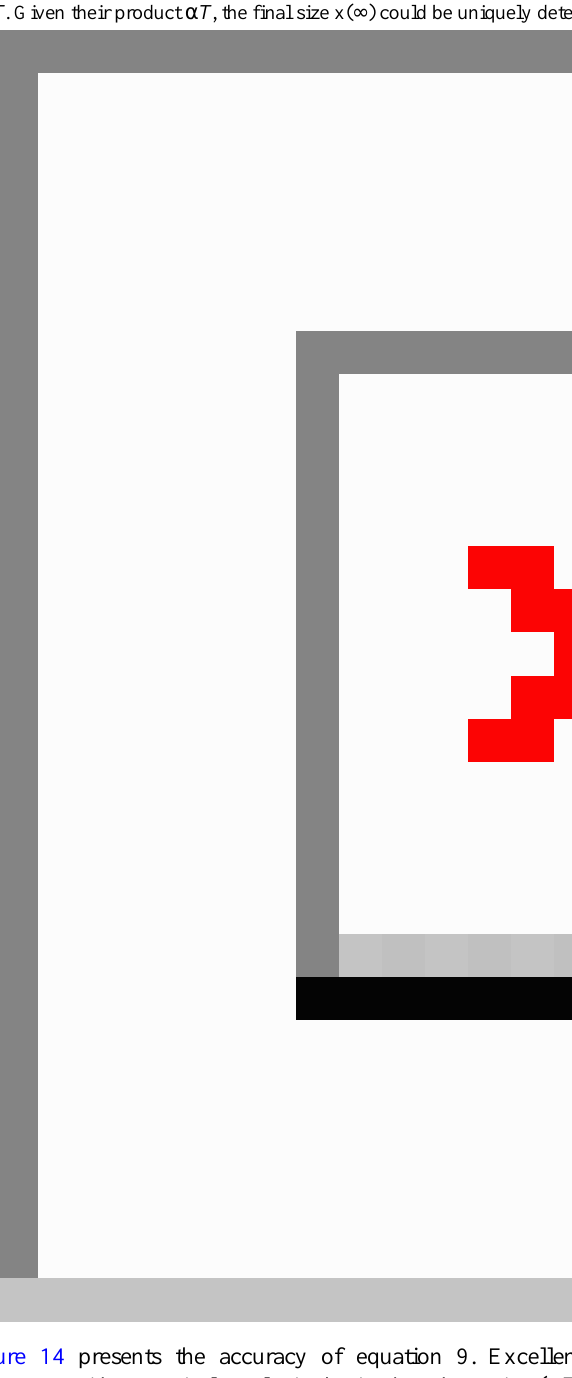
Figure 13. Effect of α T on x( ∞ ). Model PART1 was applied with parameter values same as those in Figure 3 except for transmission rate α and